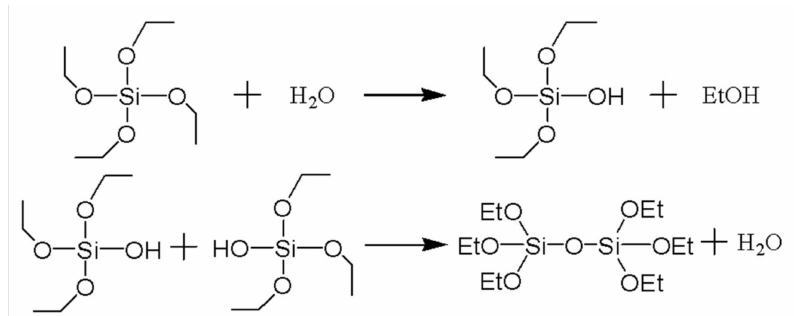
Figure 5. Hydrolytic condensation of